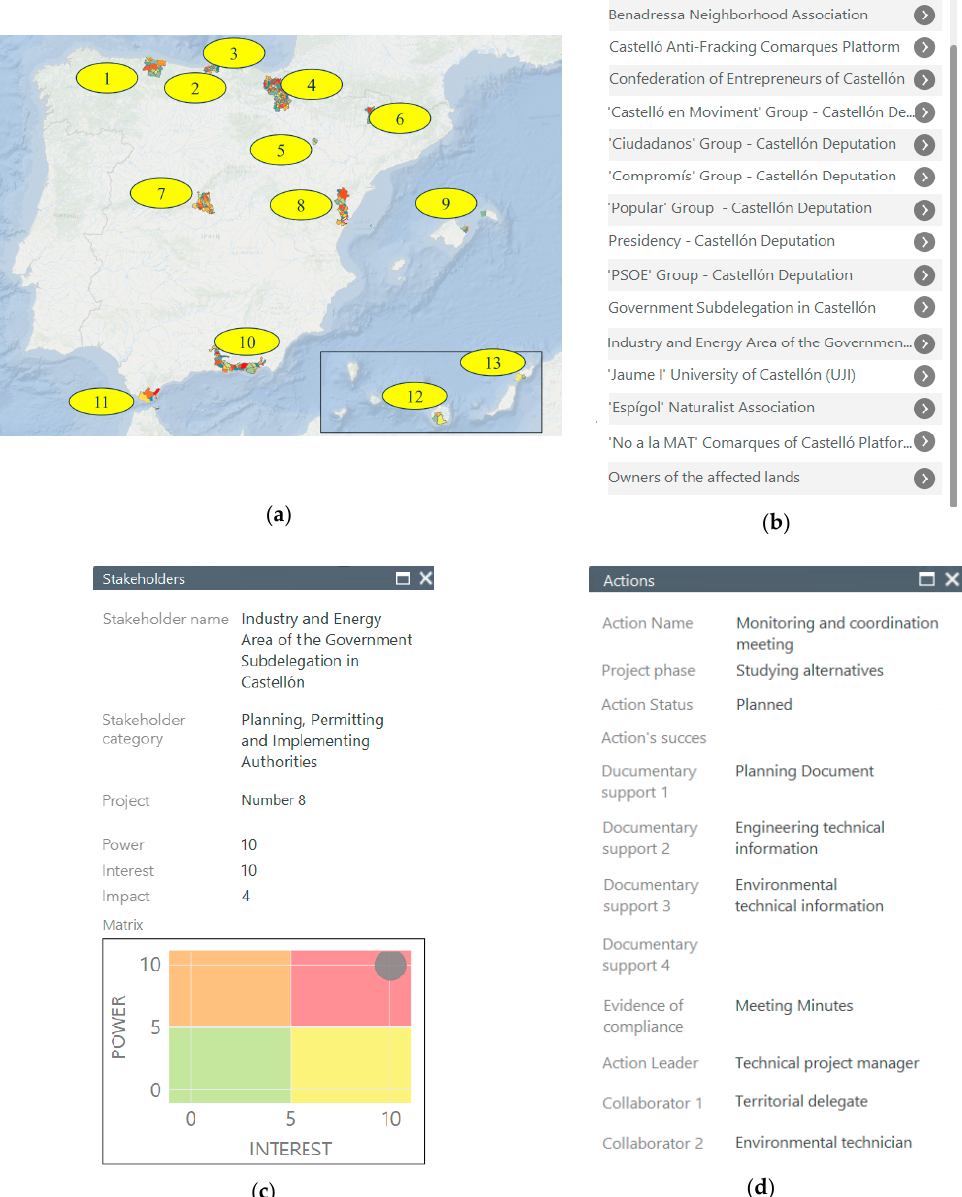
Figure 8. ( a ) Geographical areas of influence of the 13 projects managed with the proposed methodology; ( b ) list of stakeholders associated with an area of influence; ( c ) description of a stakeholder; ( d ) example of action with a